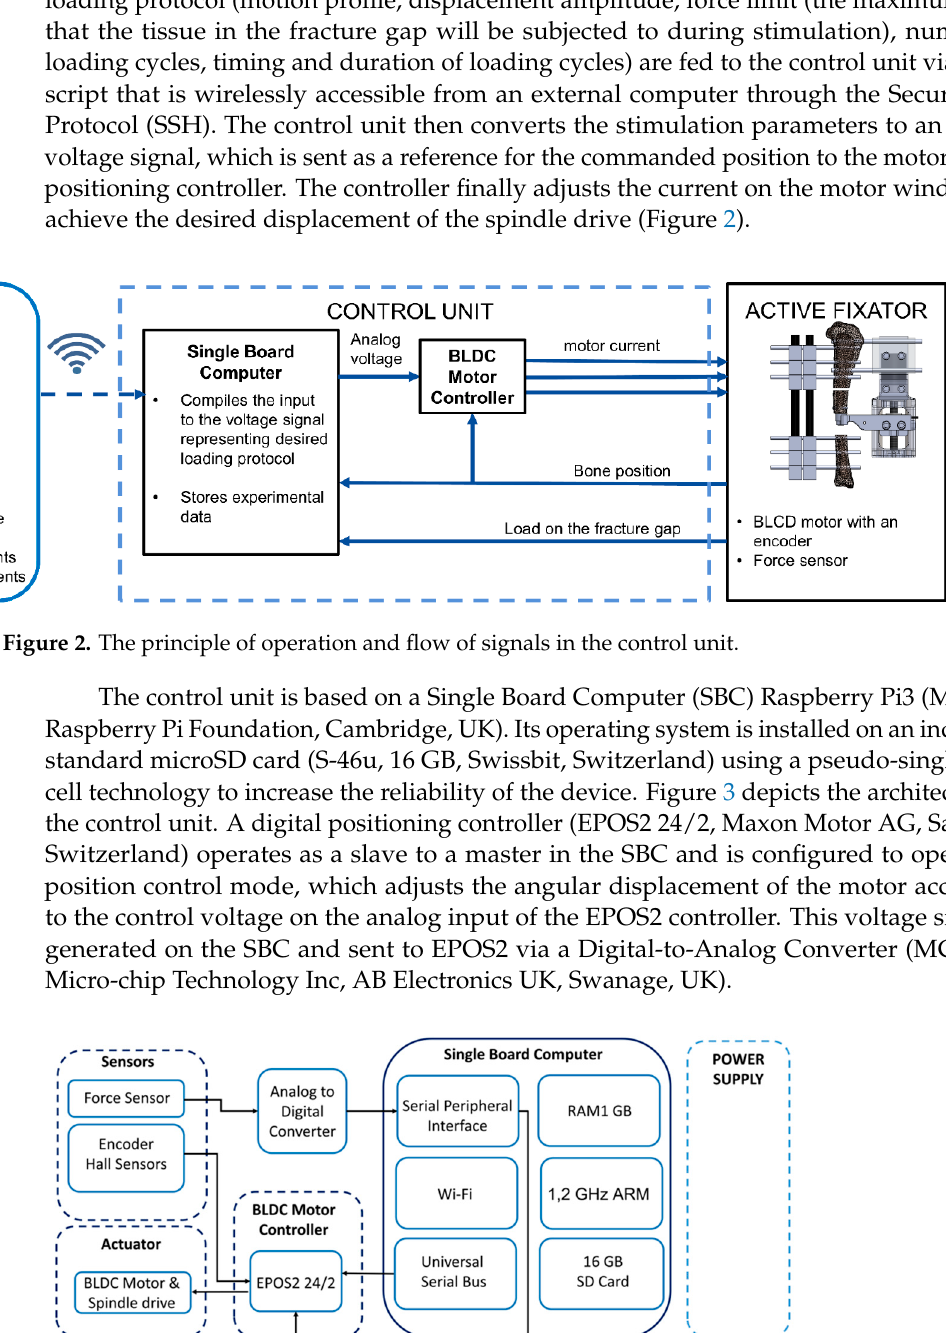
Figure 1. Configuration of the fracture model. The unilateral external fixator transfers forces from physiological weight-bearing from the proximal to the distal bone fragments (red line), while the experimental defect remains unaffected. The Brushless Direct Current (BLDC) motor actuates the spindle drive, which in turn moves the mobile bone fragment along the longitudinal bone axis.